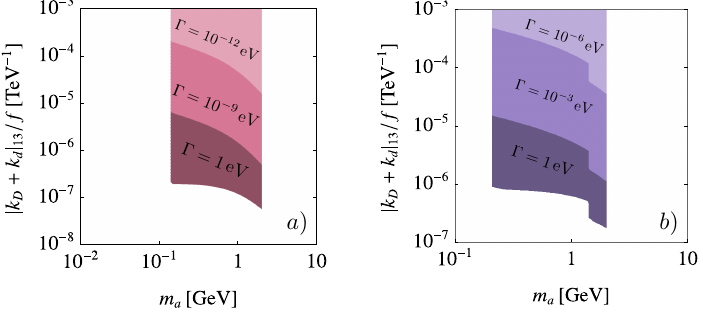
Figure 8 . Constraints on the flavor-violating ALP couplings [ k d ] 13 and [ k D ] 13 from B meson decays, collected in table 1, for different values of the total ALP width. The color-coding indicates the final state: blue for invisible final states, yellow for ALP decays into photons, red for a → e + e − decays and purple for a → µ + µ − decays.